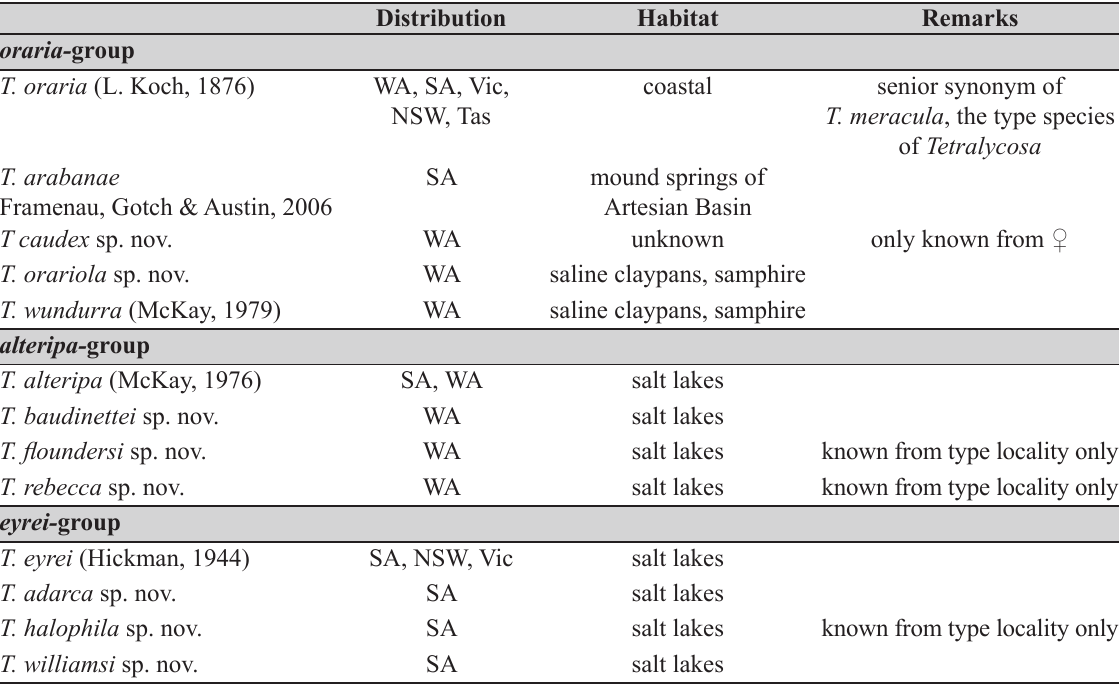
Table 4. Distribution of the species of Tetralycosa . Abbreviations: NSW = New South Wales; SA = South Australia; Tas = Tasmania; Vic = Victoria; WA = Western Australia.